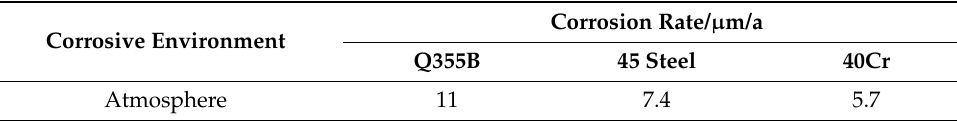
Table 8. The corrosion rates of different steels in Beijing.